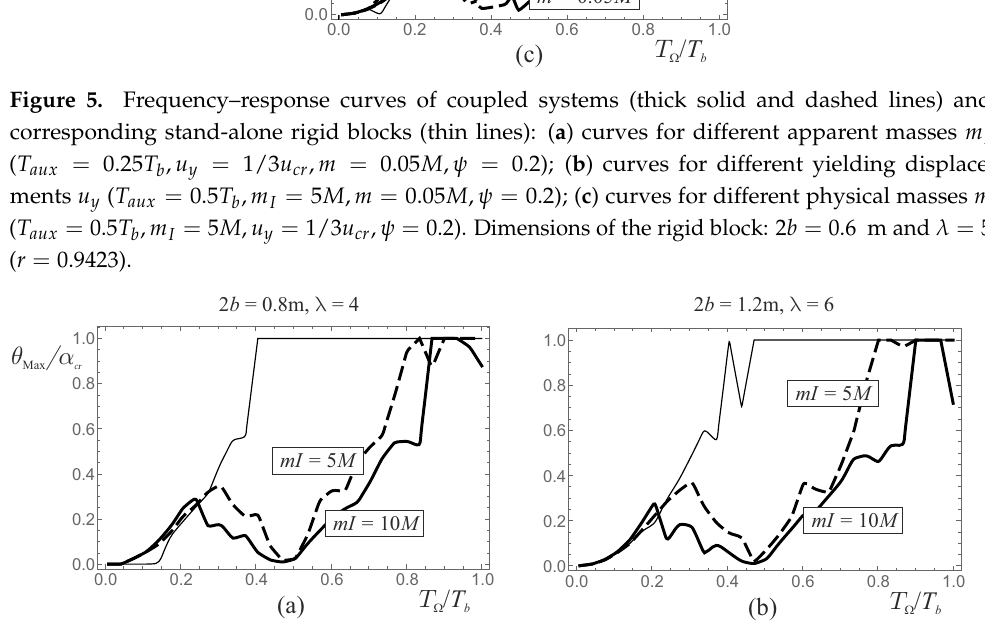
Figure 6. Frequency–response curves of coupled systems (thick solid and dashed lines) and corresponding stand-alone rigid blocks (thin lines): ( a ) curves for different apparent masses m I and dimensions of the rigid block 2 b = 0.8 m and λ = 4 ( r = 0.9118); ( b ) curves for differ- ent apparent masses m I and dimensions of the block: 2 b = 1.2 m and λ = 6 ( r = 0.9595), ( T aux = 0.5 T b , m = 0.05 M , u y = 1/3 u cr , ψ =